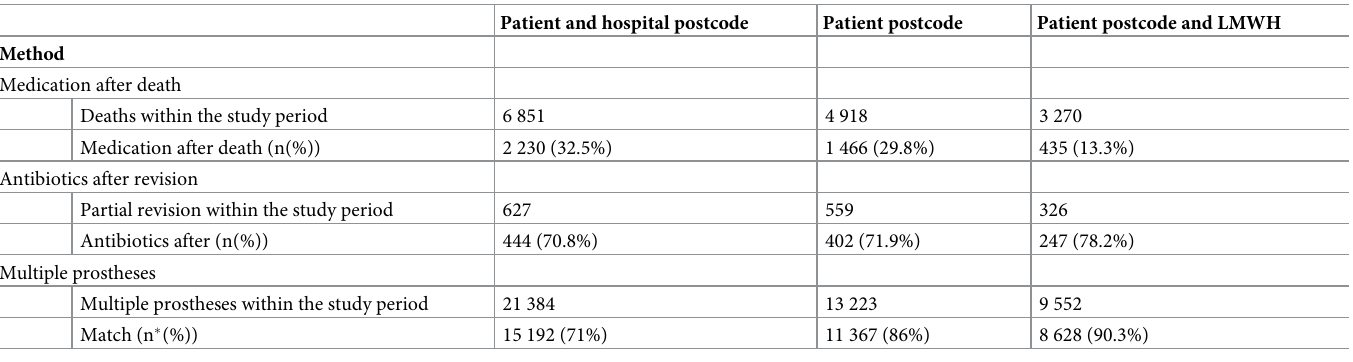
Table 3. Linkage quality checks in different selections of the linked population on several